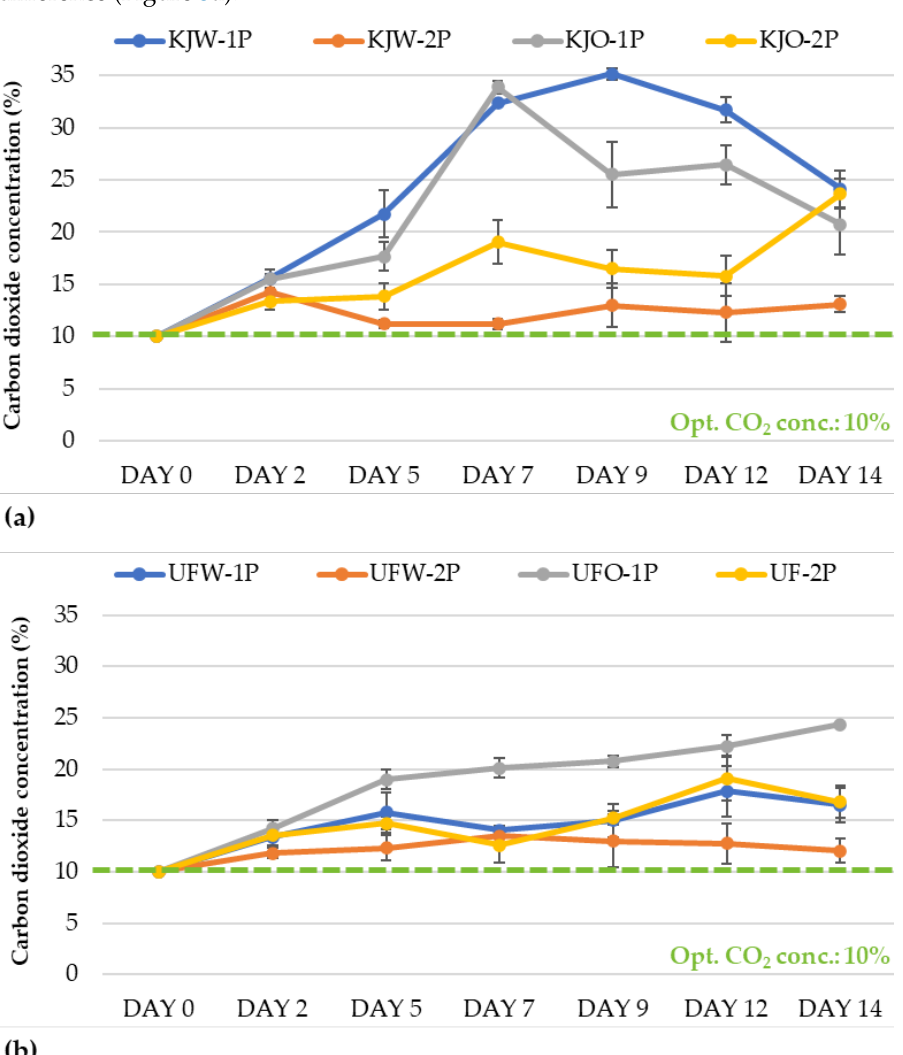
Figure 3. Change in headspace carbon dioxide concentration in modified atmosphere packages of ( a ) ‘Kántorjánosi’ and ( b ) ‘Újfehértói fürtös’ sour cherries with different washing pretreatments.